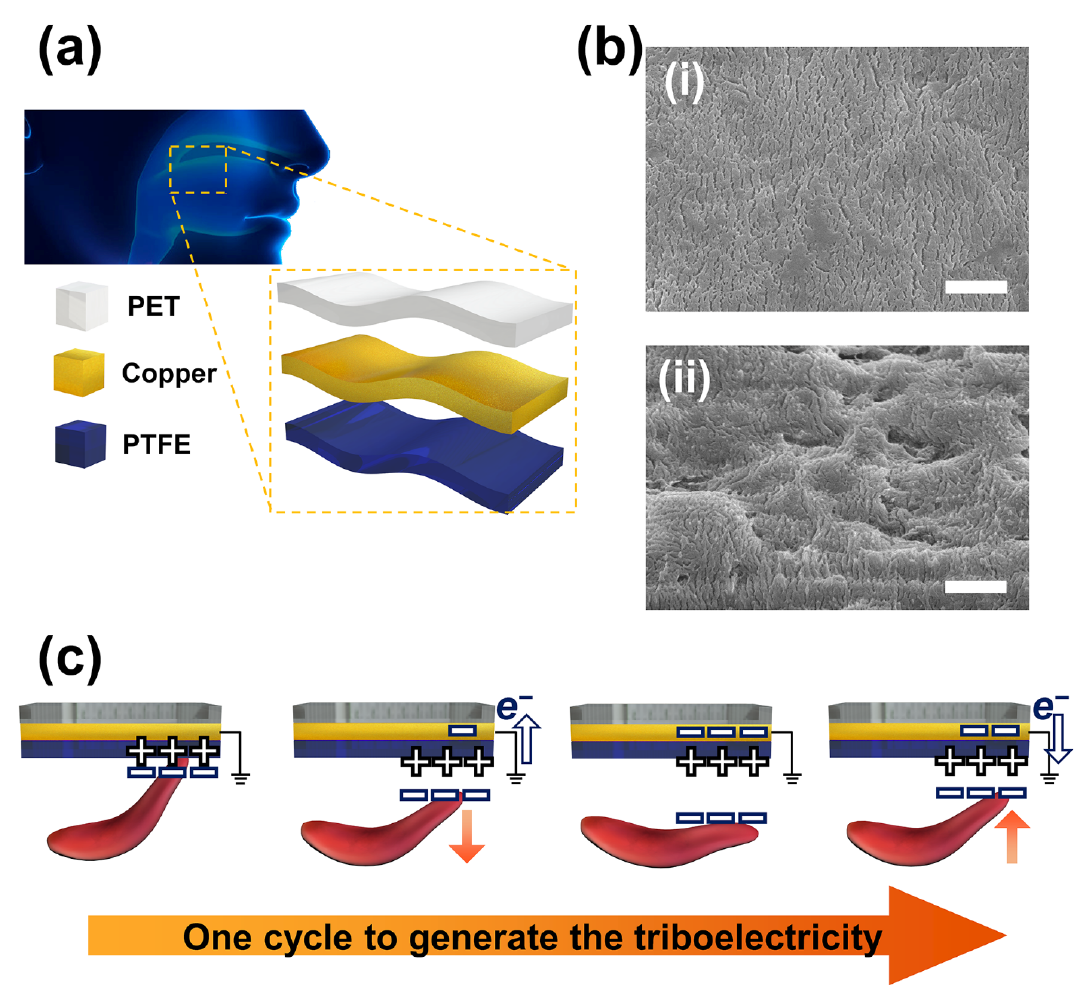
Figure 1. Diagram of the fabricated TSR. ( a ) The schematic image of the TSR. ( b ) The surface of the PTFE film observed by the SEM with scale bar indicating 1 μ m. ( i ): Surface of bare PTFE. ( ii ) Surface of tilted PTFE. ( c ) The working mechanism to generate triboelectricity for one cycle with the TSR.